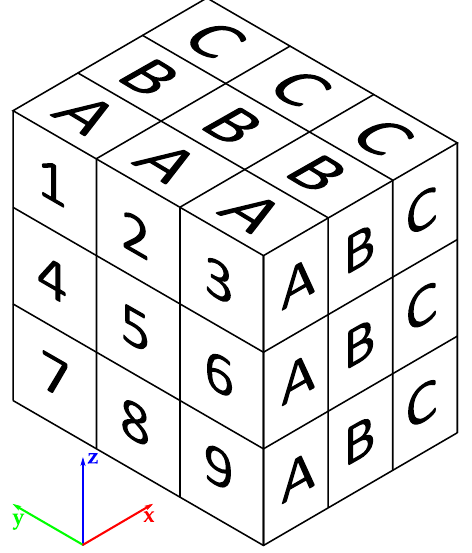
Figure 3. The placement and designations of the zones inside the print